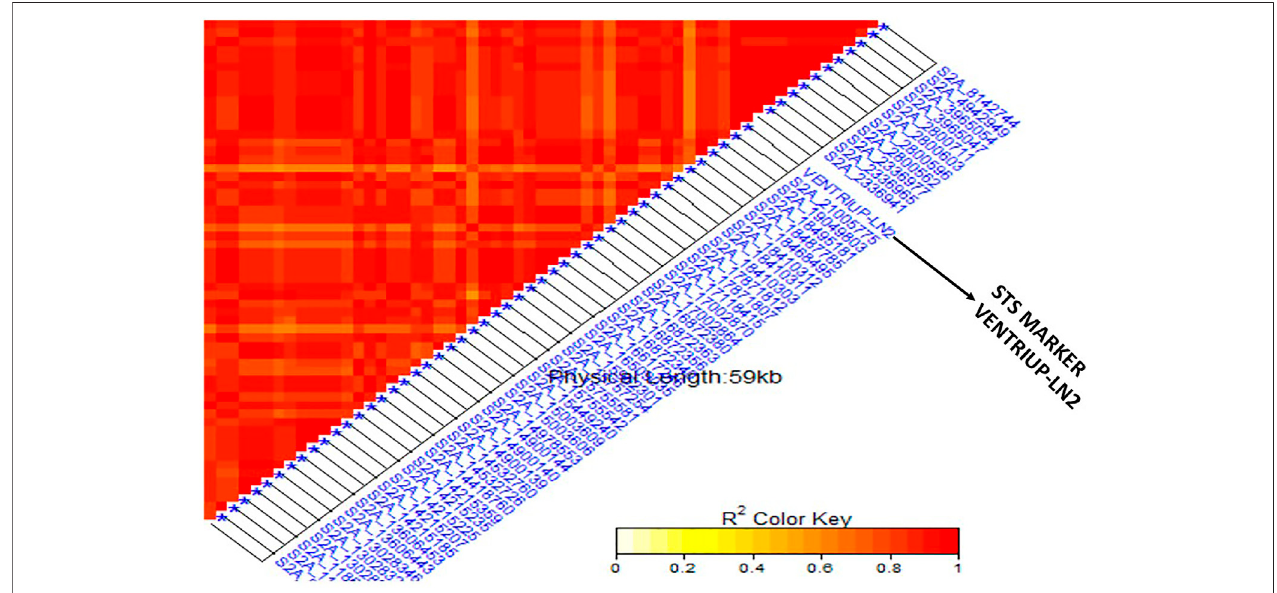
FIGURE 5 | Linkage disequilibrium (LD) analysis in the tested genotypes: heatmap of LD between the speci fi c STS marker “ VENTRIUP-LN2 ” for Sr38 resistance gene and the 59 SNPs on 2A showed highly signi fi cant LD with the marker.